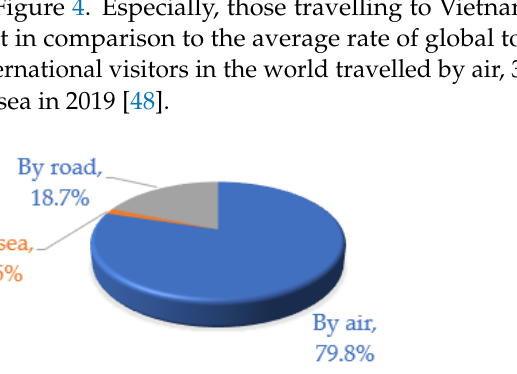
Figure 4. International tourists by mode of transport. Source: VNAT (2019).